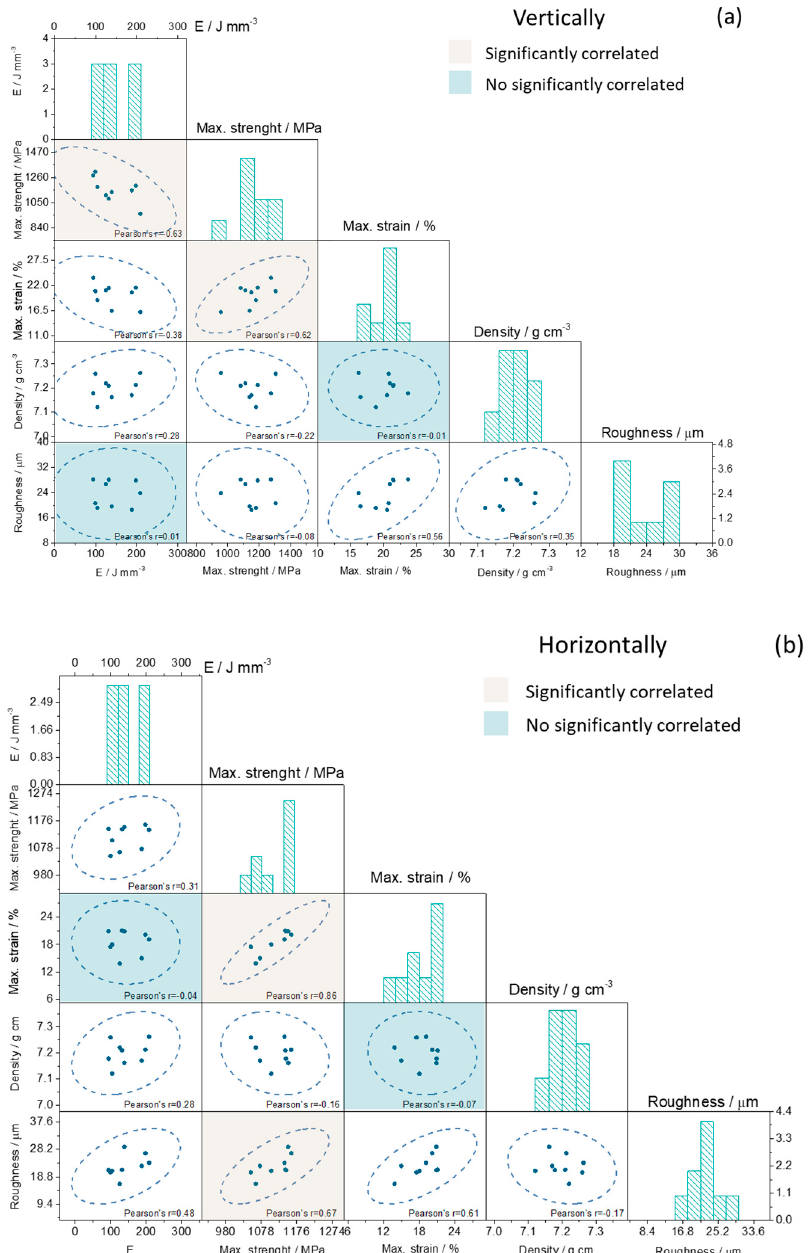
Figure 10. Scatter matrix graph of the correlation between the energy density (E) with intensive and mechanical properties measured of ( a ) vertical and ( b ) horizontal as ‐ built samples.